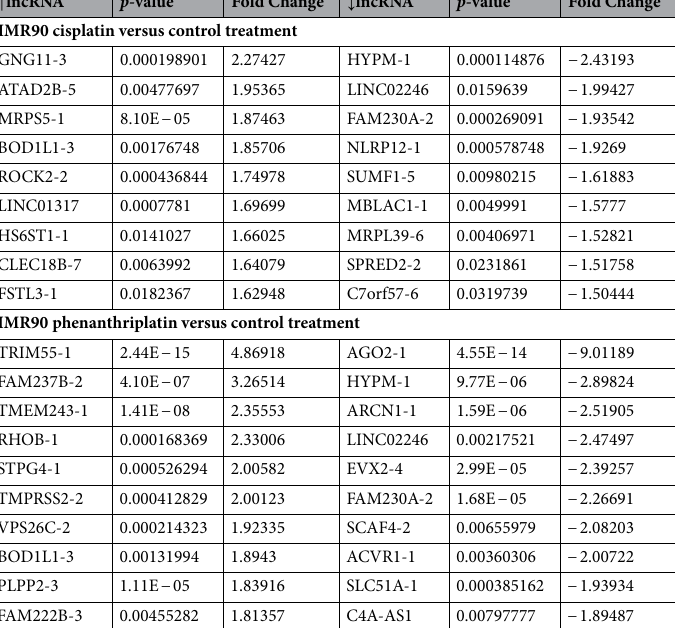
Table 2. Top up- and downregulated lncRNAs in cisplatin or phenanthriplatin treated IMR90 cells versus IMR90 controls (N = 4; p ≤ 0.05; fold change ≥